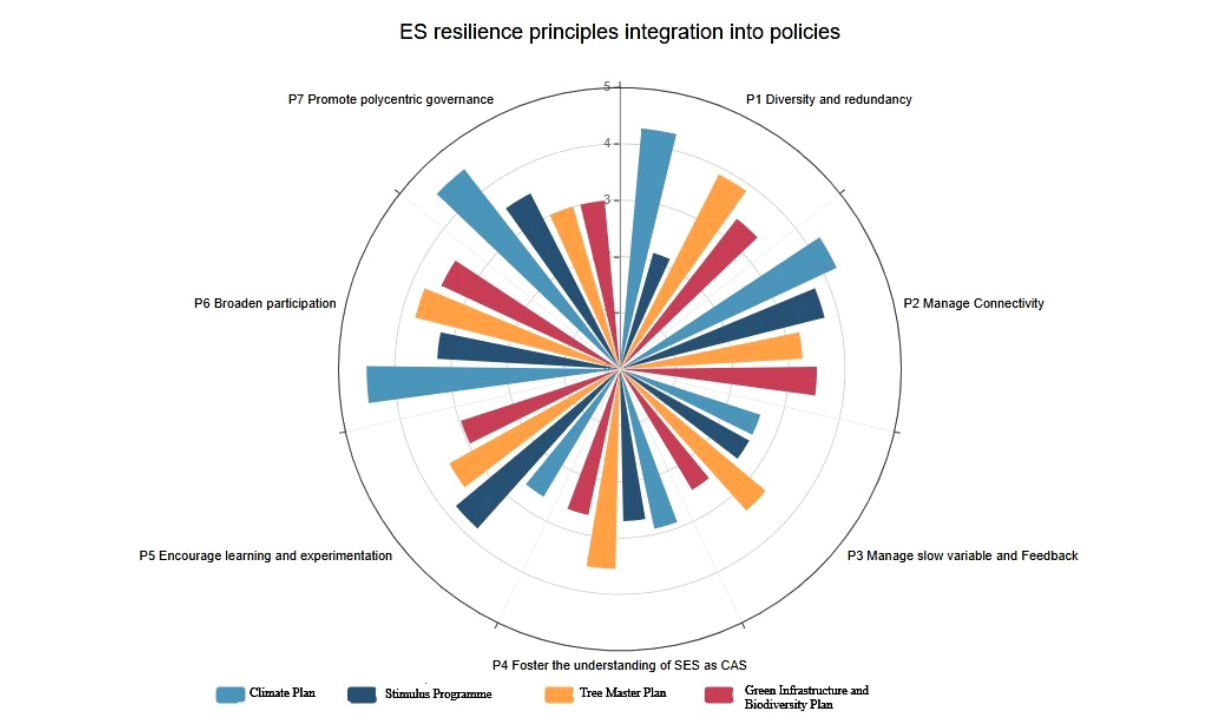
Fig. 2. Results from the policy analysis using the urban ecosystem services resilience matrix. The integration of the ecosystem services (ES) resilience principles (P1 to P7) into each green infrastructure policy ranges from 1 (low incorporation) to 5 (high incorporation). SES = social- ecological system; CAS = complex adaptive